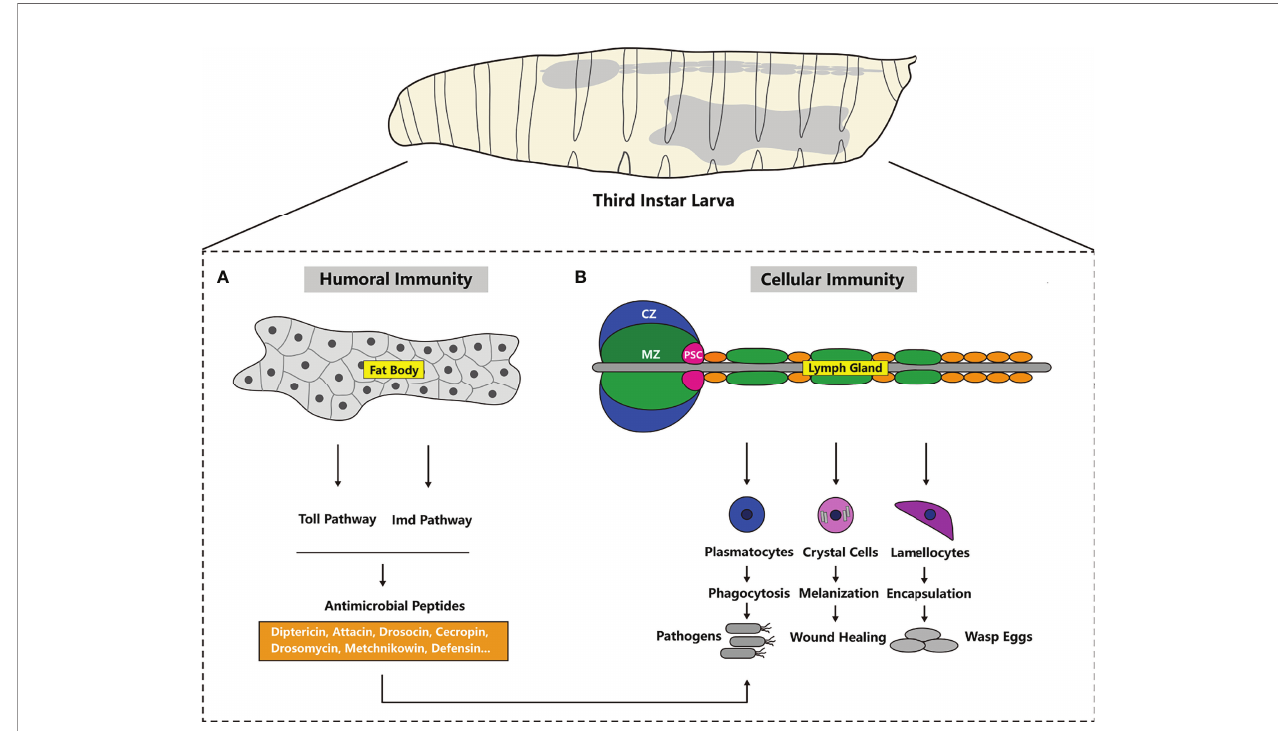
FIGURE 1 | Overview of Drosophila host defenses. (A) The hallmark of humoral immunity (also known as the systemic immune response) is antimicrobial peptides (AMPs, i.e., Diptericin, Attacin and others) secretion by the fat body; this process is mainly modulated by the Toll and Imd pathways. (B) Cellular immunity depends on three types of hemocytes in Drosophila : plasmatocytes, crystal cells and lamellocytes. In addition the lymph gland is the main hematopoietic tissue in the larval stage. Plasmatocytes and lamellocytes can phagocytose and encapsulate pathogens, respectively, and crystal cells participate in wound healing through